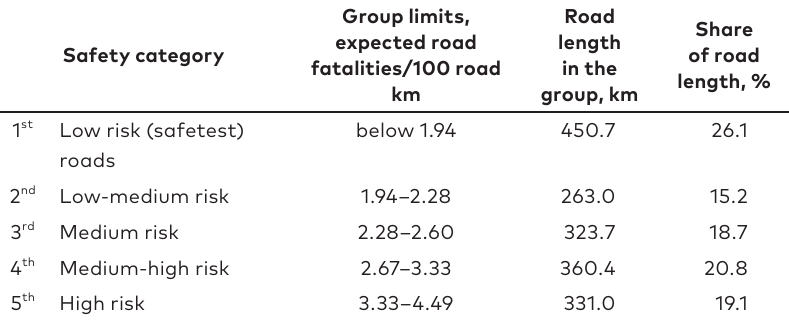
Table 6. Data on road safety